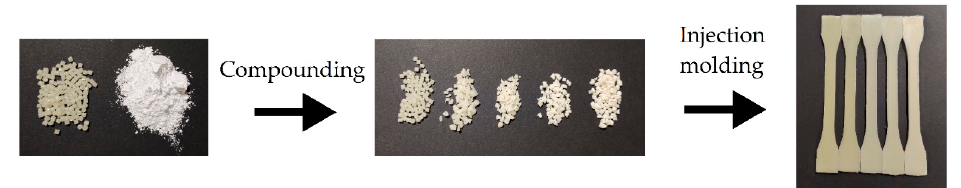
Figure 6. Processing steps carried out to prepare the poly(3-hydroxybutyrate- co